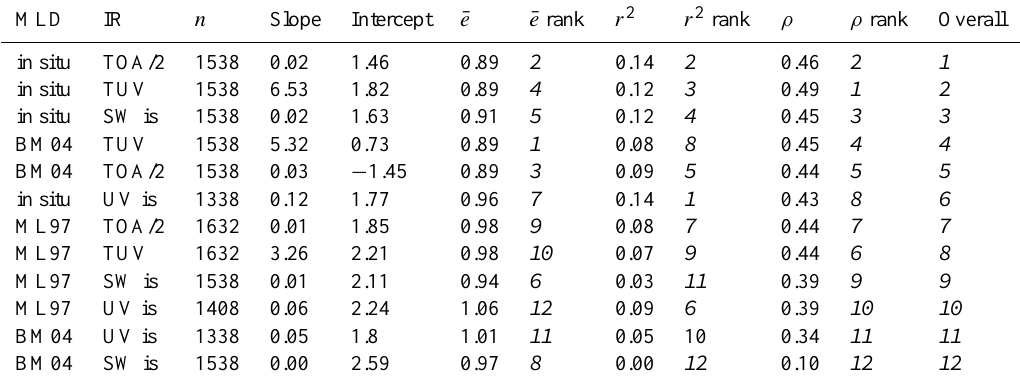
Table 4. Performance summary for the VS07 and MI09 relationships. These values were determined from the regression equations as applied to the SE Pacific region. The first column indicates which of the three mixed layer depth (MLD) datasets was used, these were either determined in situ or from the ML97 or BE04 climatologies. The second column contains the incoming radiation (IR) dataset used, one of shortwave radiation measured in situ (SW is), the estimated surface shortwave radiation (TOA/2), UV radiation from the NCAR Tropospheric Ultraviolet and Visible Radiation Model (TUV) or UV measured in situ (UV is). Further details of these data are given in the methods section. The following columns contain the number of points ( n ), the slope and intercept of the relationship, the mean residuals ( ¯ e ,nM), the correlation ( r 2 ) and the Spearman coefficients ( ρ ). In the column to the right of each of the assessment criteria the rank (ascending) is given. The final column is the overall performance rank based on the sum of the three other